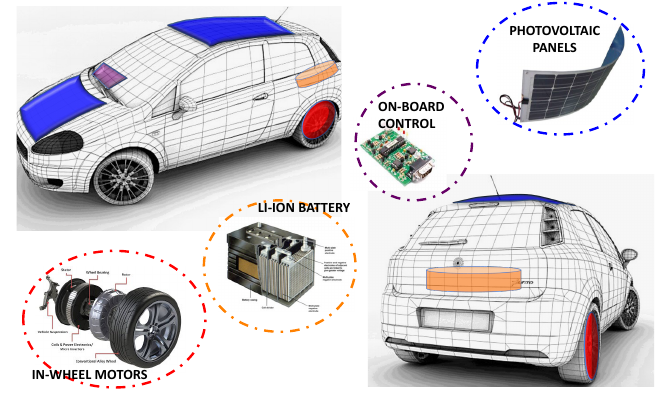
Figure 2. Schematic depiction of the solar hybridization